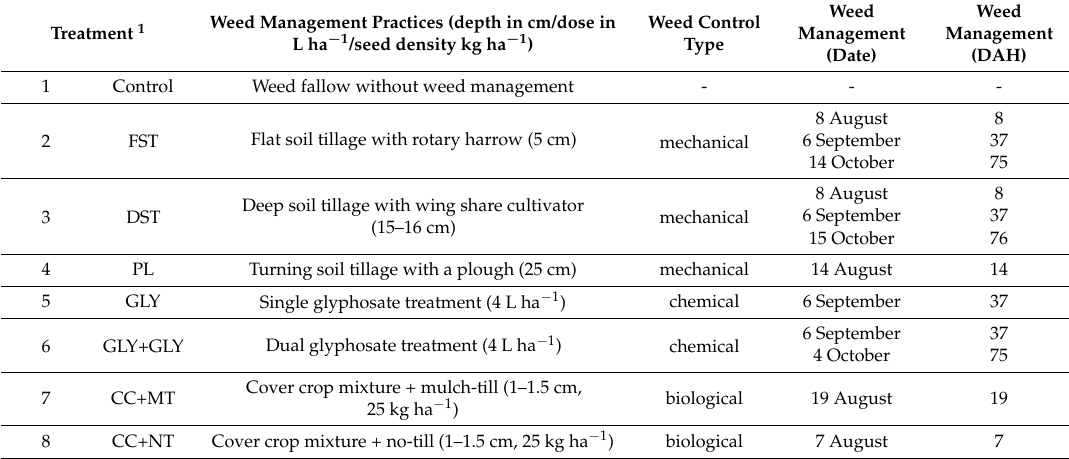
Table 2. Weed management treatments, weed control type and treatment dates for the experimental field sites at Binsen and Risp. Weed management dates include dates for tillage, herbicide applications, and sowing dates for the cover crop mixtures. (DAH = Days after